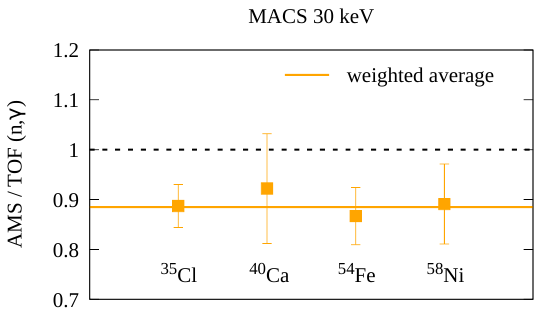
Figure 1. Ratio between the Maxwellian-averaged neutron- capture cross sections of 35 Cl, 40 Ca, 54 Fe and 58 Ni at 30keV mea- sured using AMS [10–13] and those measured using ToF [14– 18]. The AMS data are on average 12% lower than the ToF data, for more details see